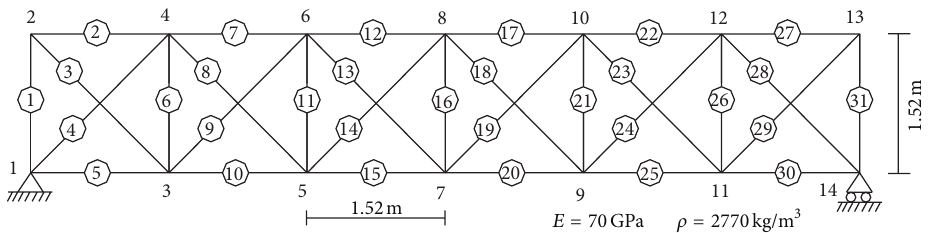
Figure 3: Thirty-one-bar truss structure (Example 2).